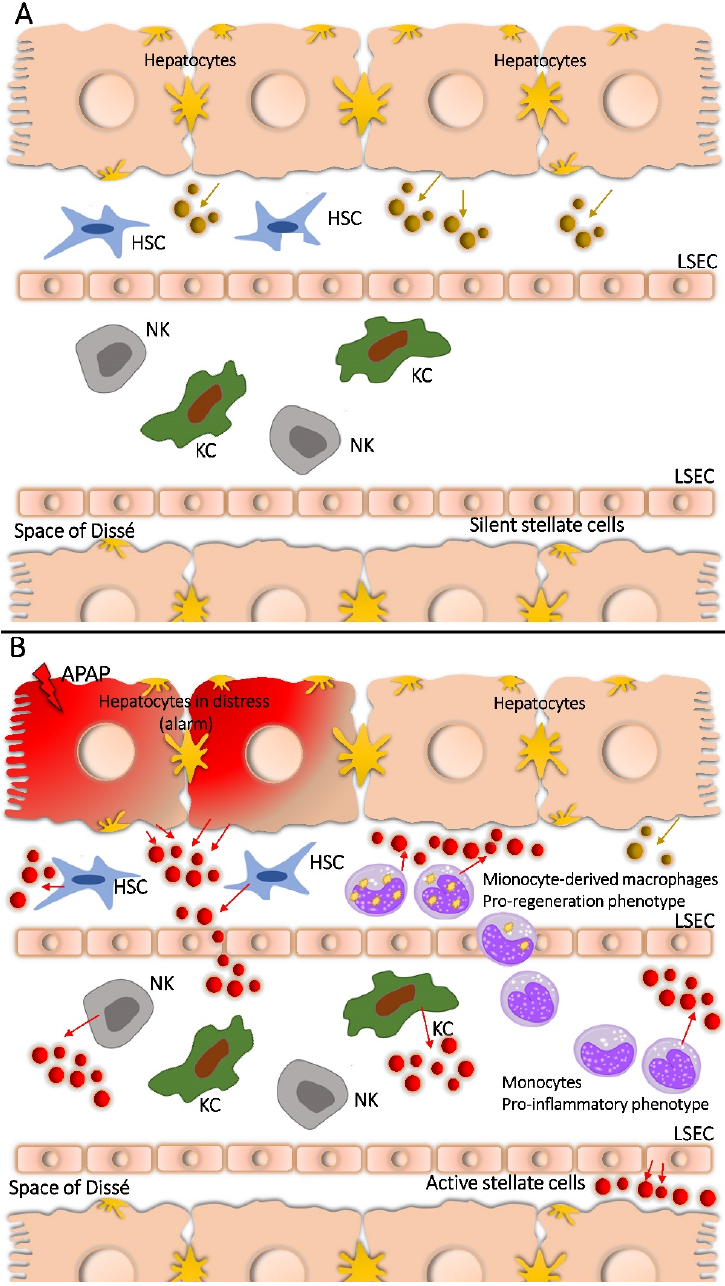
Figure 4. Liver and immune cells before ( A ), and after treatment with sub-toxic APAP dose ( B ). Distressed hepatocytes mobilize pro-inflammatory monocytes and other non-parenchymal liver cells like Kupffer cells, hepatic stellate cells, and endothelial cells. Hepatocyte necrosis, as a con- sequence of APAP overdose, did not occur under these experimental conditions, but changes in EVs proteomes shed by all involved liver cells indicated the liver was experiencing significant stress under the given conditions. KC—Kupffer cells, HSC—Hepatic stellate cells, NK—natural killer cells.